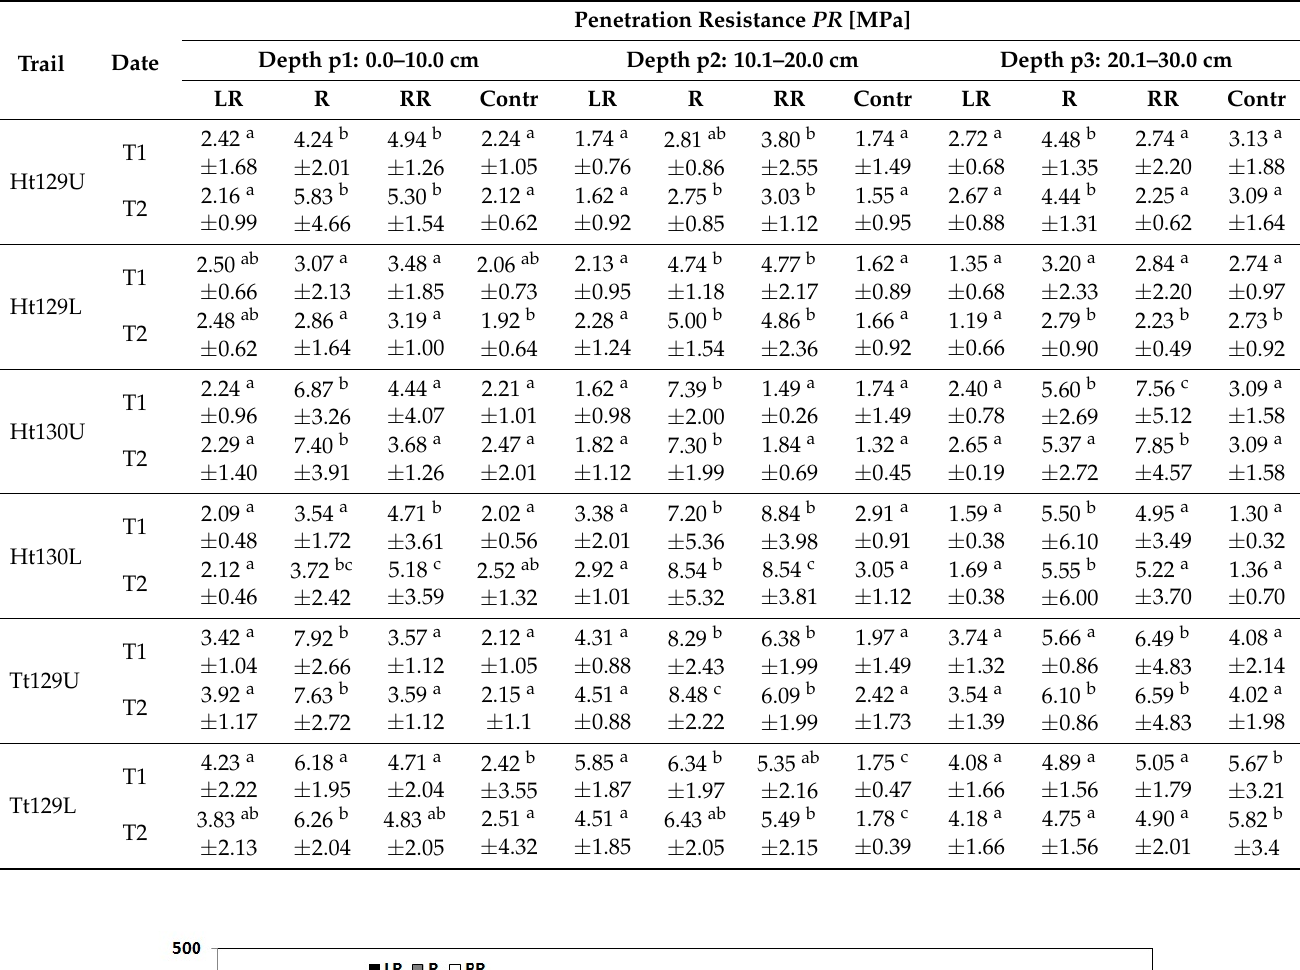
Table 4. Mean (±SD) soil compactness in trails and control plots (superscript a–d: homogeneous groups determined by Tukey’s test, p < 0.05).